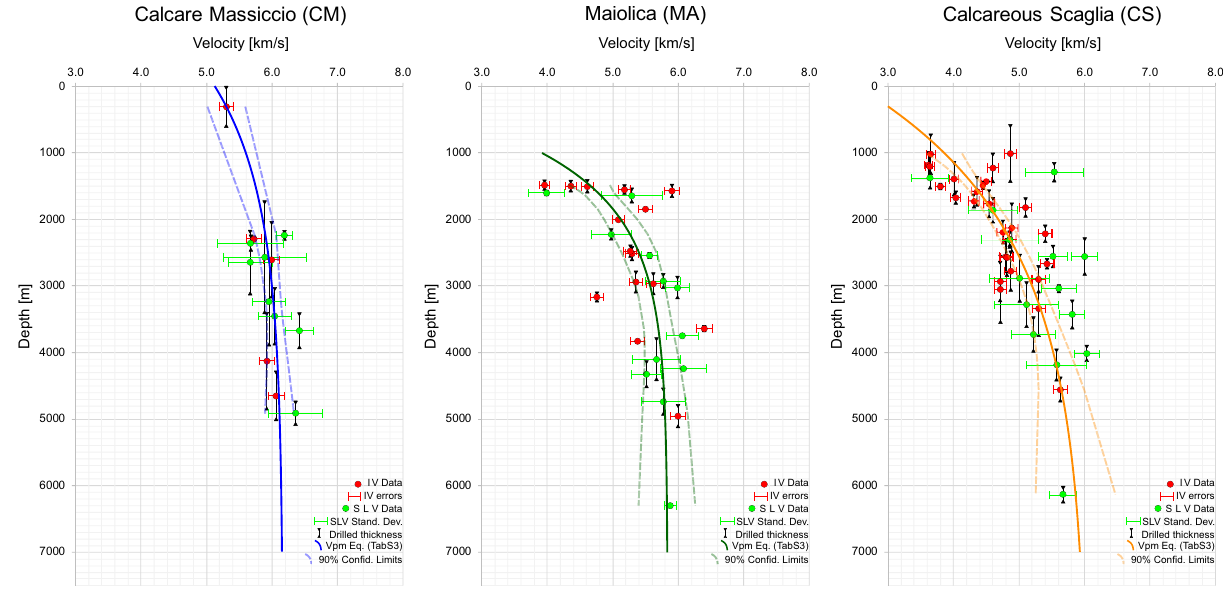
Figure 6. Mean velocities vs mean depths for boreholes that drilled Calcare Massiccio, Maiolica and Calcareous Scaglia. Green symbols are for Sonic logs data (SLV), Red symbols are for Check shot (IV). Vertical black bars indicate the thickness of each lithology drilled by the wells. Horizontal red and green bars represent respectively the IV data errors (2% following 47 ) and the standard deviations of the SLV data. Colored (blue, green and orange) lines for each formation have been drawn following the equations reported in Supplementary Table S3 and the dashed lines represent the 90% confidence limit derived from such analysis. To infer the weighted best fit with an exponential function, the objective function implemented in Matlab has been applied to the available data. The procedure then gives the best coefficients (Supplementary Table S3) by minimizing the sum of square